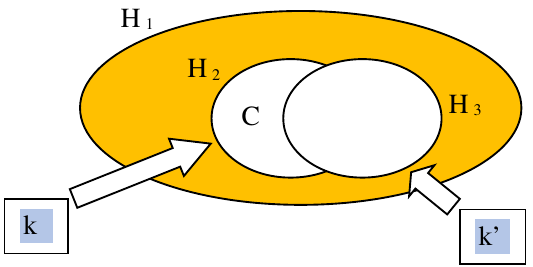
Figure 3. Keyed Learning—the correct key k helps select a hypothesis space H 2 that is easier to learn, including a predictive classifier C